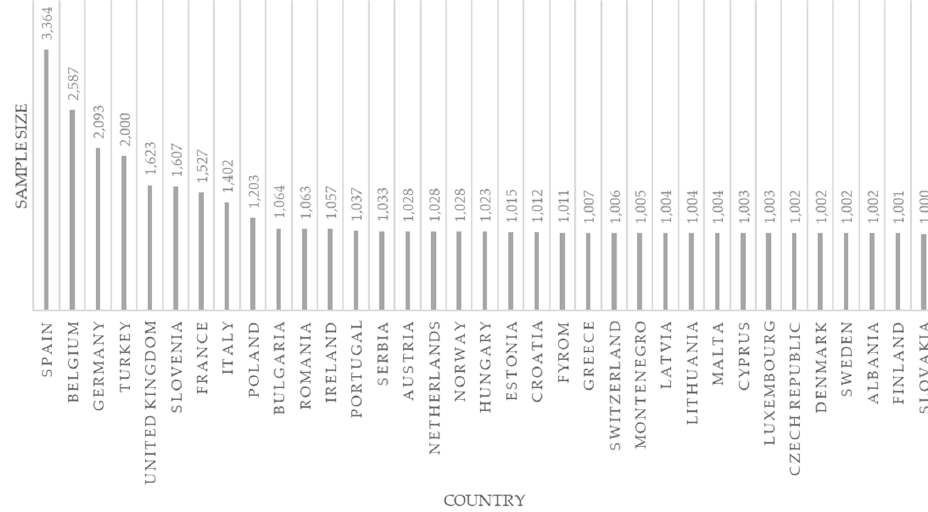
Figure 1. Sample sizes by country.